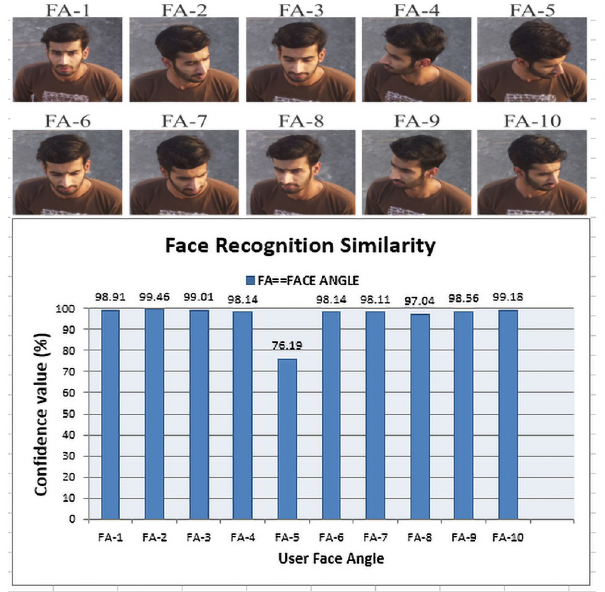
Fig 7. Face recognition accuracy with respect to different face angles (FA1—FA10) during the drone flight.